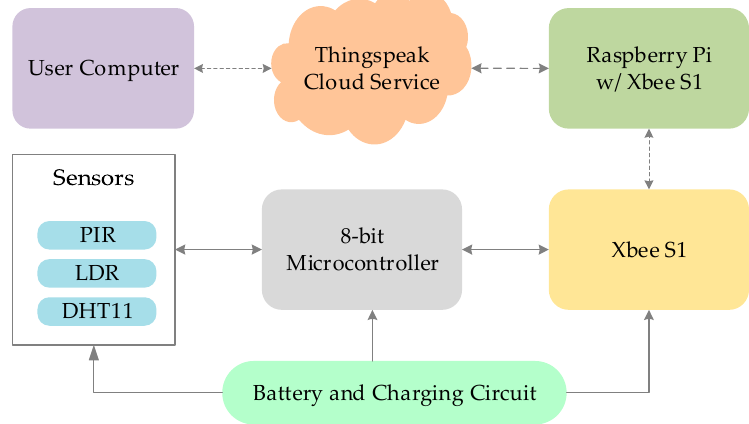
Figure 8. System Architecture for Occupancy Monitoring. Table 1. Current consumption in the occupancy monitoring system.